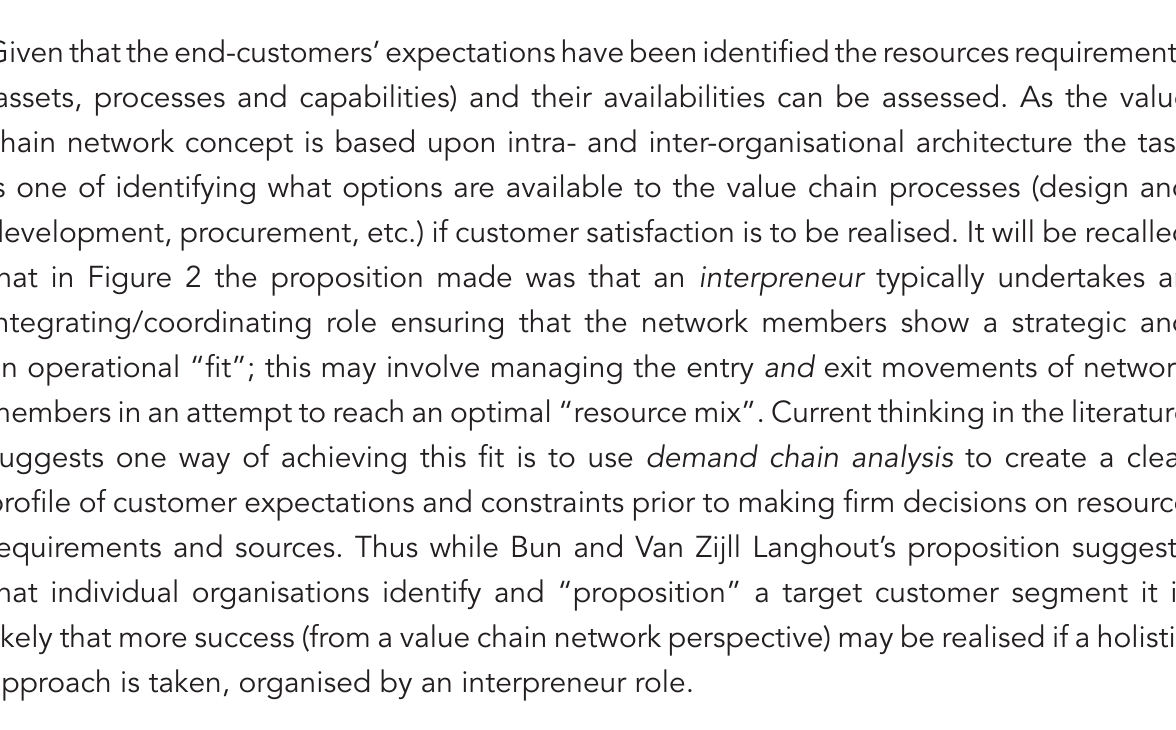
Figure 3: Matching value chain member objectives and resource requirements and availability